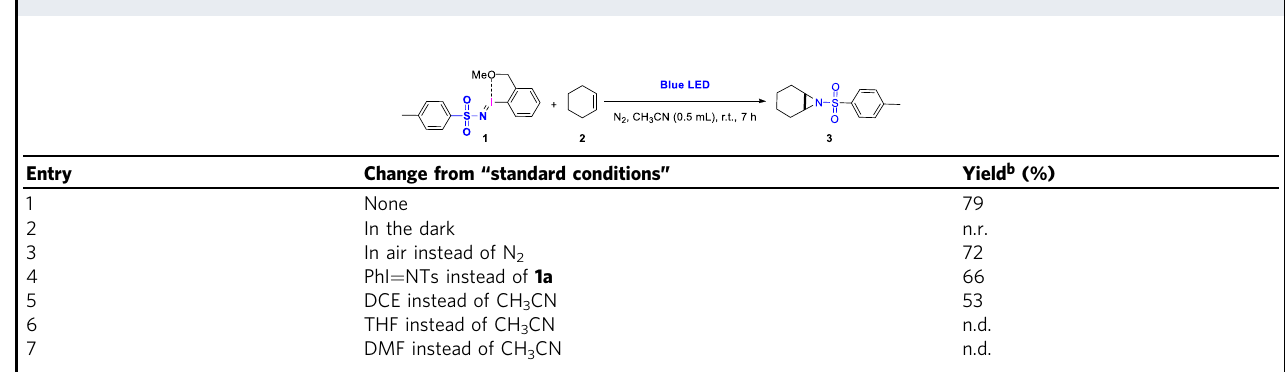
Table 1 Optimization of the reaction conditions for photo-induced aziridination of alkenes a